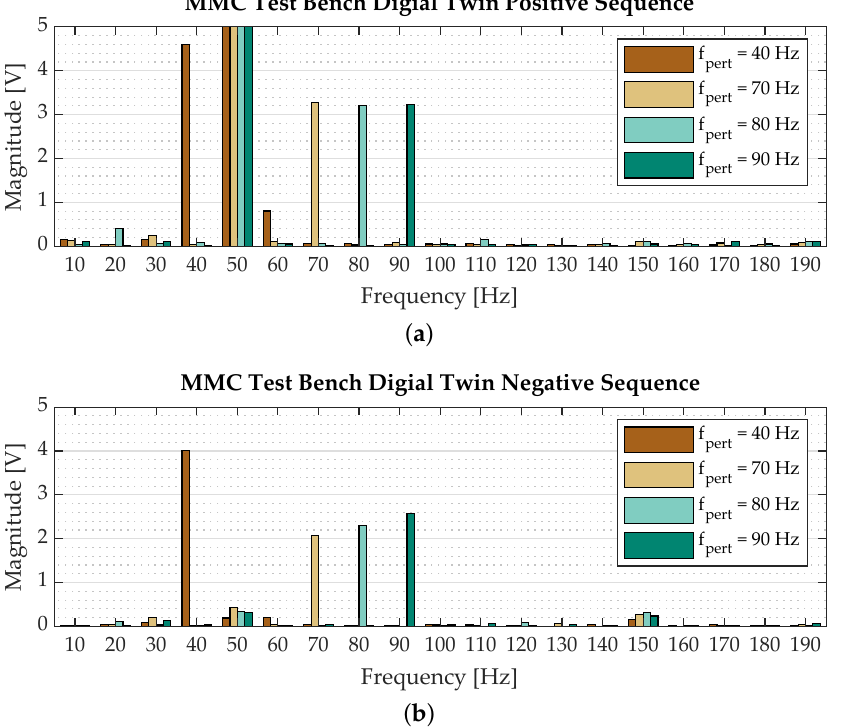
Figure A2. MMC TB digital twin voltage response spectrum with ( a ) positive-sequence and ( b ) negative-sequence current